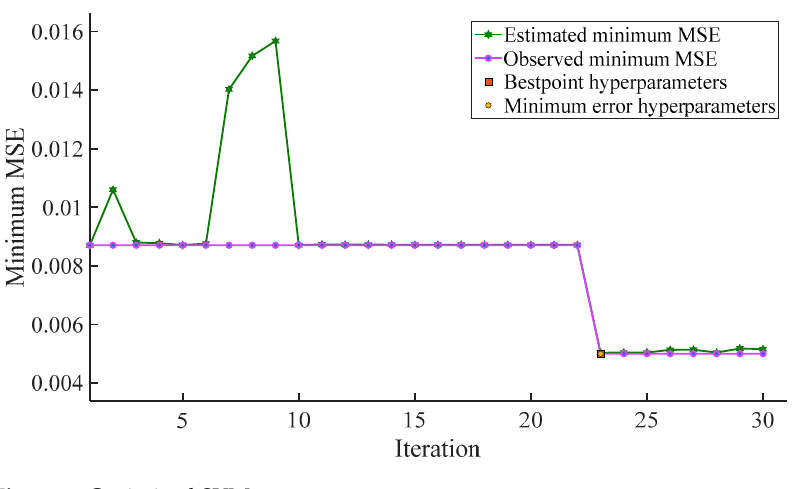
Figure 6. Optimized SVM.